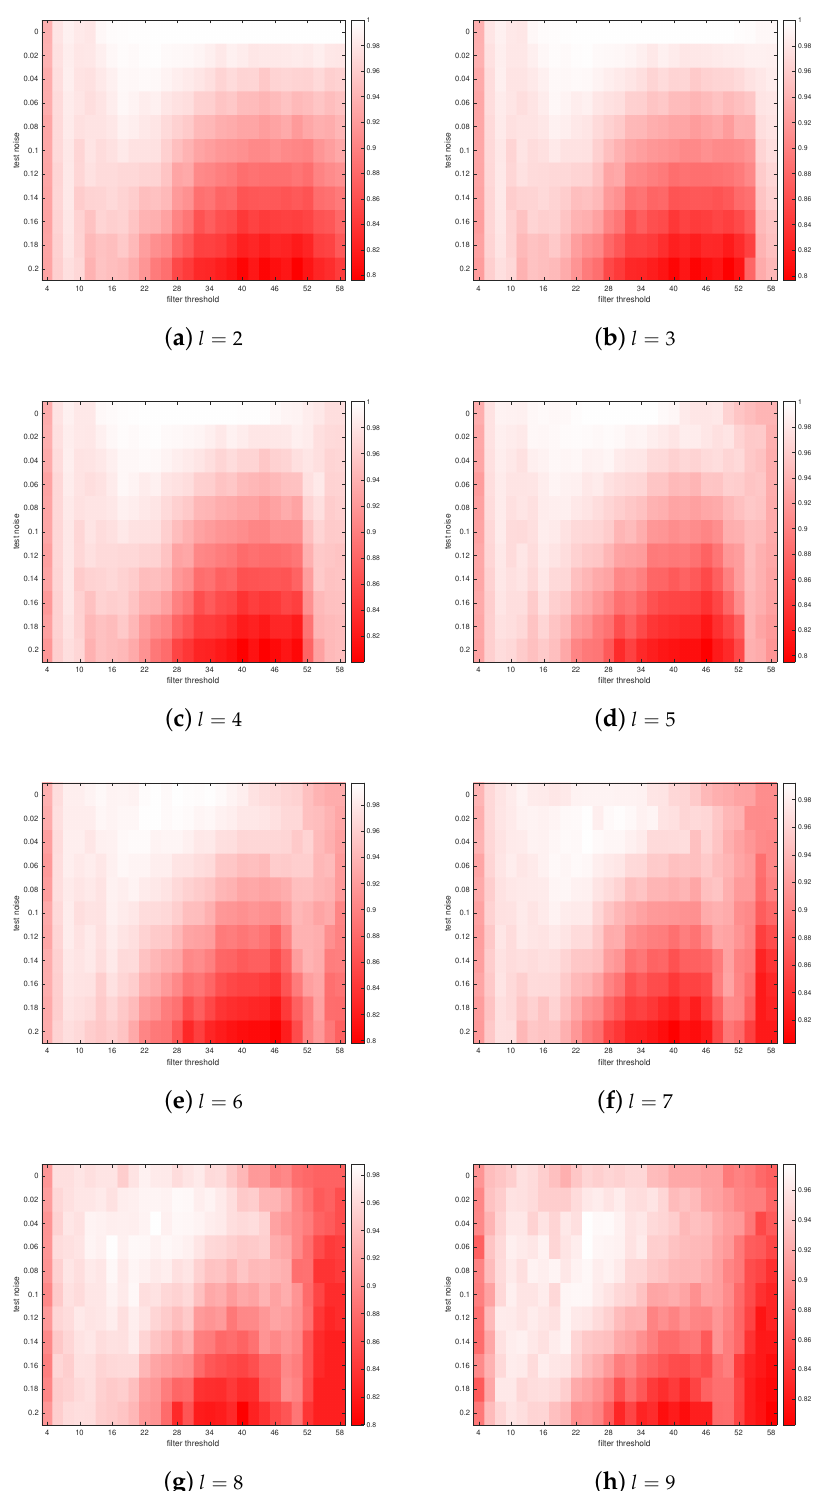
Figure 3. Performance score C p for digit zero with various astrocytic coverage areas. In each sub- figure, the vertical axis denotes various levels of the salt-and-pepper noise at the testing stage. The horizontal axis denotes the threshold f 0 (increased by 2 units) of the low-pass